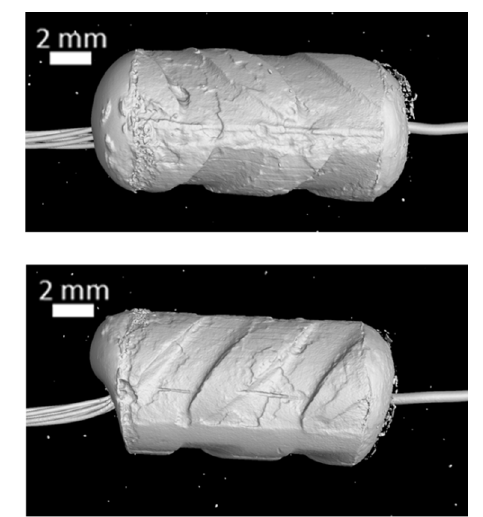
Figure 4. The sample (shown from different angles) is contaminated with a free Cl content of 2.07 %/wt. binder (X ‐ ray Tomography (CEA Saclay, France)) (from [45]).